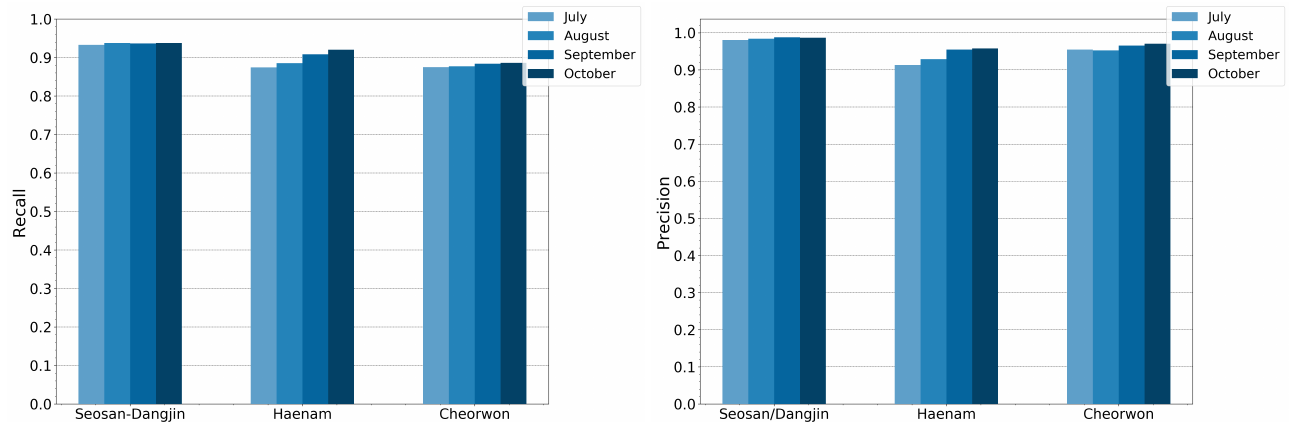
Figure 17. RF recall and precision for incrementally larger feature spaces. Classifications were run in July, August, September and